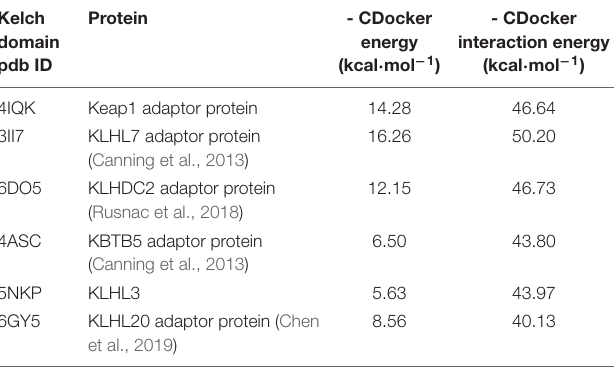
TABLE 2 | Docking energies for NMBSA into Kelch adaptor proteins.